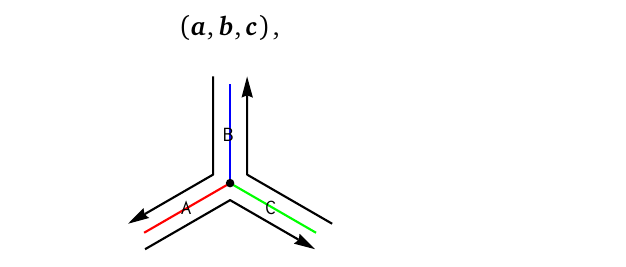
Figure 2: Definition of the orientation of the loops for a black vertex (the definition is opposite on white